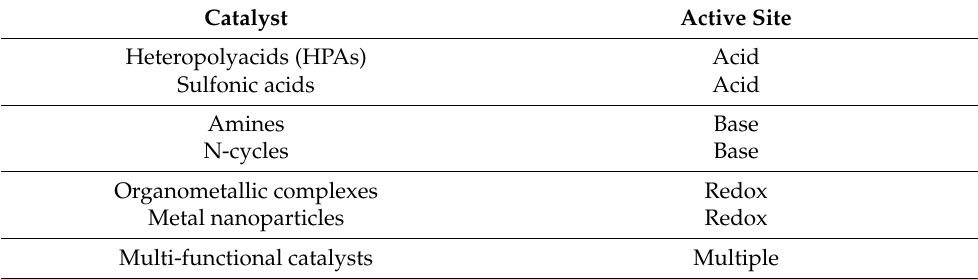
Table 1. Families of hybrid catalysts described in this review article. Catalyst Active